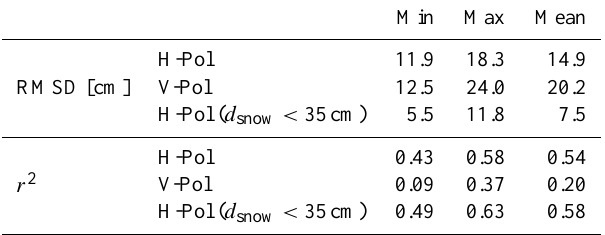
Table 3. Minimum, maximum, and mean root mean square devia- tions RMSD and coefficients of determination r 2 for the IceBridge snow thicknesses and the snow thicknesses as retrieved from SMOS brightness temperatures for the 15 simulation scenarios. The val- ues are given for the retrieval with horizontally and with vertically polarised brightness temperatures, as well as for horizontally po- larised brightness temperatures, when only retrieved snow thick- nesses d snow < 35cm are considered. Min Max Mean H-Pol RMSD [cm]